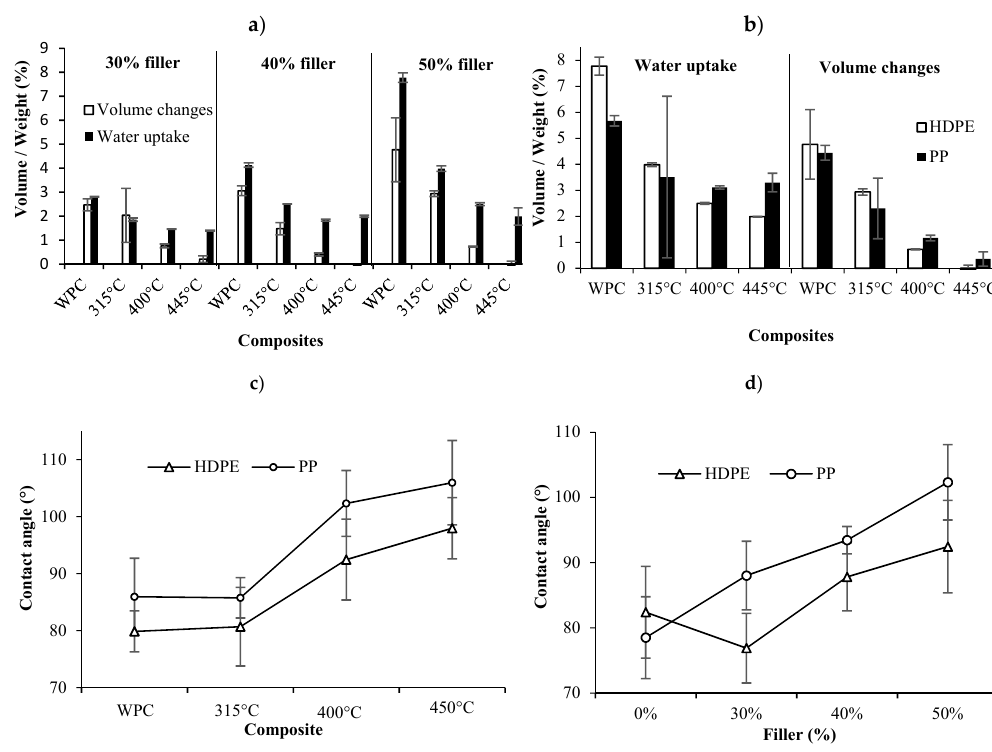
Figure 8. (a ) Water uptake and volume changes after 6 months immersion water testing with wood and biochar composites made with HDPE; ( b ) e ff ect of polymer matrix (HDPE or PP) on water absorption and volume changes of wood and biochar composites made with 50% filler after 6 months testing; ( c ) e ff ect of pyro-gasification temperature on the contact angle of the same materials in ( b ); ( d ) e ff ect of filler content of BS400PC on the contact angle.